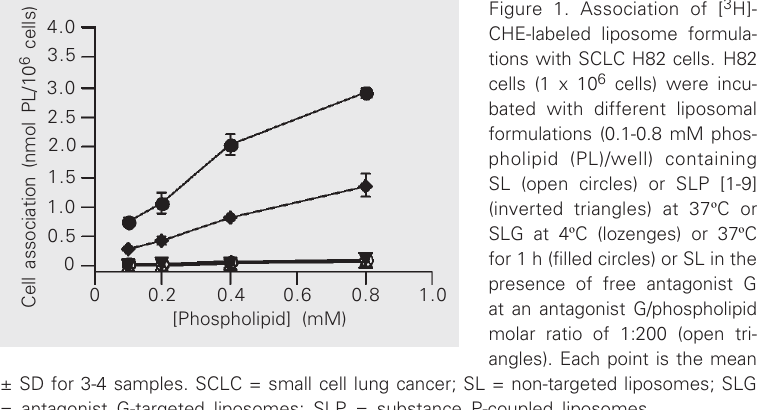
Figure 2. Association of HPTS- containing liposomes with SCLC H82 cells. H82 cells (2 x 10 6 cells) were incubated with liposomes (0.8 mM phospho- lipid/well) at 37 º C for 1 h. H82 cells were incubated with SLG (A), SL (B) or SLP [1-9] (C). After washing with cold PBS, the cells were visualized with an LSM-510 laser-scanning confocal microscope. HPTS = 8-hydroxypyrene-1,3,6-trisul- fonic acid, trisodium salt; SCLC = small cell lung cancer; SLG = antagonist G-targeted lipo- somes; SL = non-targeted lipo- somes; SLP = substance P- coupled liposomes. Scale bar for all panels = 10